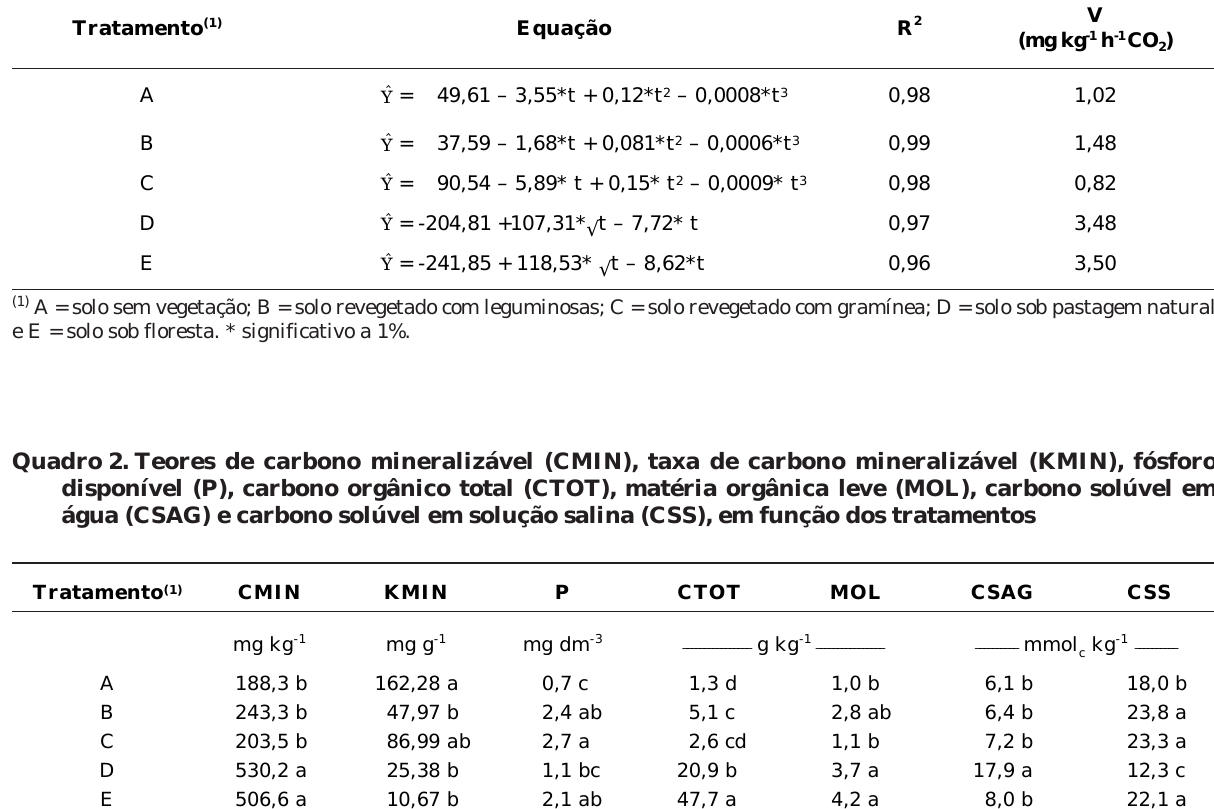
(1) A = solo sem vegetação; B = solo revegetado com leguminosas; C = solo revegetado com gramínea; D = solo sob pastagem natural e E = solo sob floresta. Médias seguidas pelas mesmas letras na coluna não diferem entre si a 5%, pelo teste Tukey.